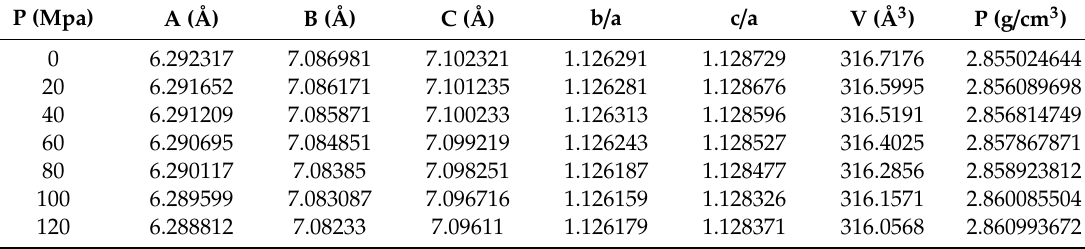
Table 4. Lattice parameters and densities of anhydrite crystals under di ff erent